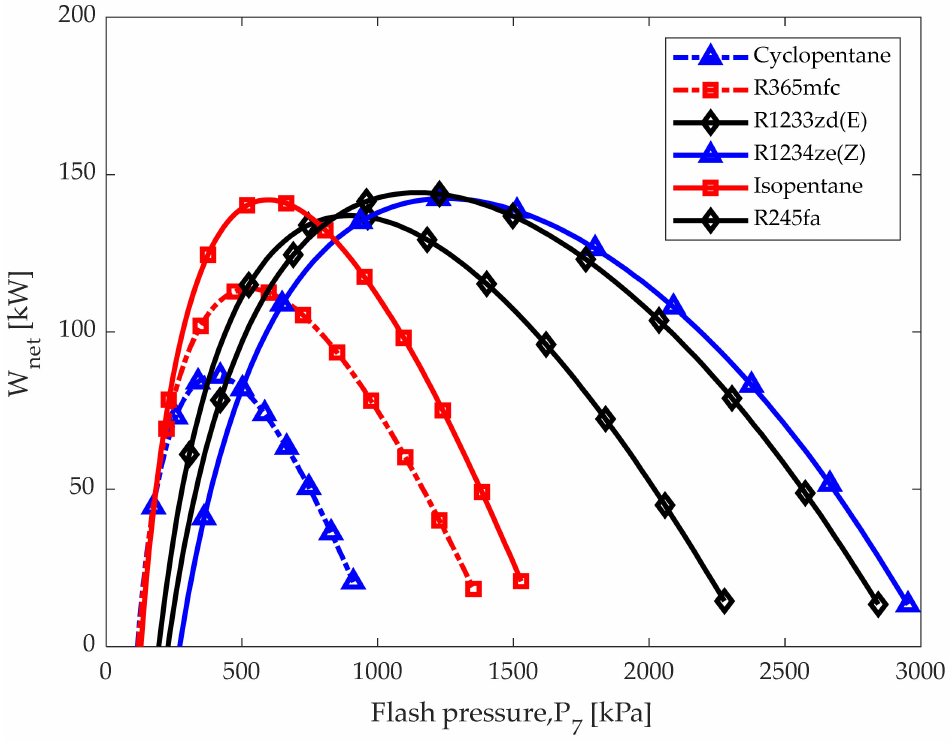
Figure 4. Effect of flash pressure on the net power outputs.